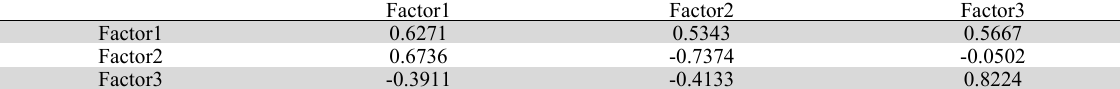
Rotation matrix of factors affecting sustainable